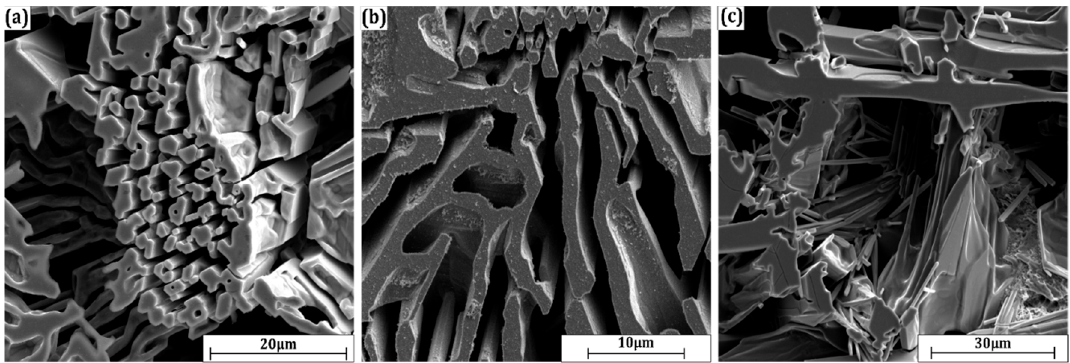
Figure 3. Representative SEM micrographs of Sample B after deep etching. The three-dimensional structure of the eutectic carbide is visible. ( a ) ‘rosette’ pattern, with the thin hexagonal rods at the center; ( b ) blade morphology; and ( c ) heterogenity in nucleation.